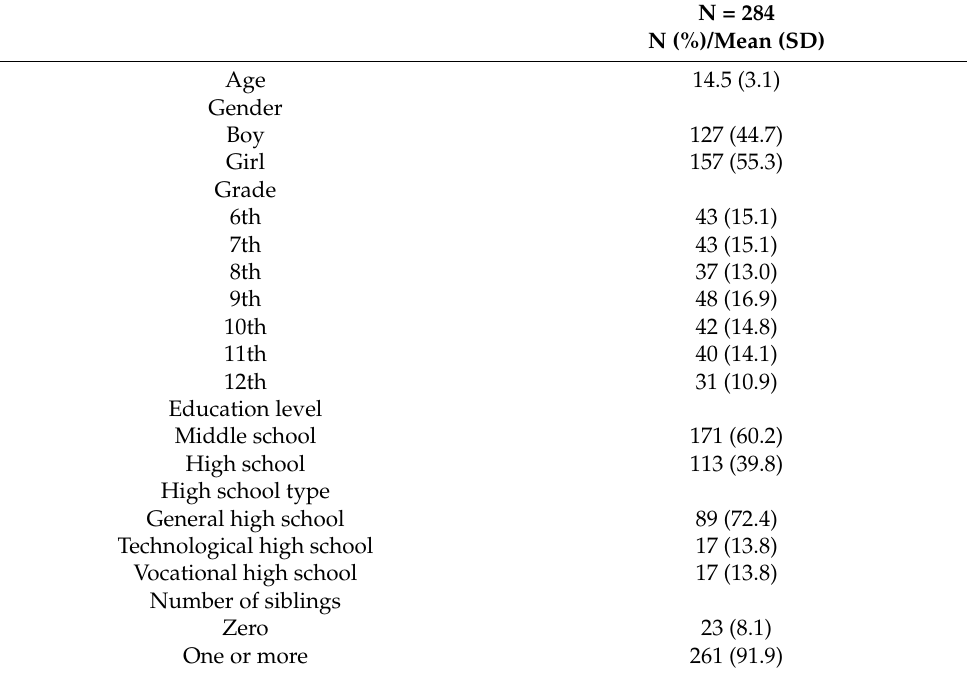
Table 1. Sociodemographic characteristics of the adolescent sample population during